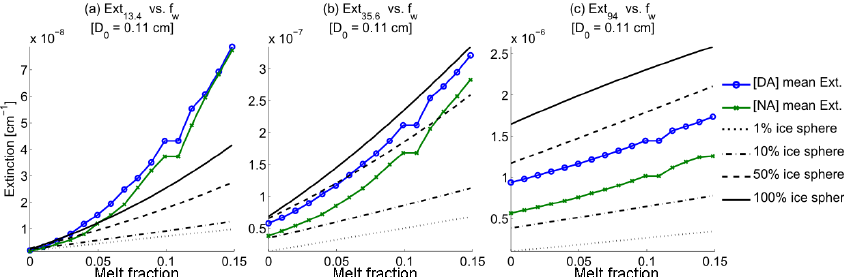
Figure 13. Volume extinction coefficient for D 0 = 0 . 11cm at (a) 13.4, (b) 35.6, and (c) 94.0GHz. The orientation-averaged single-particle extinction cross section was integrated over the same particle size distribution as was used in Fig. 11. Note different scaling on the vertical axes, including the